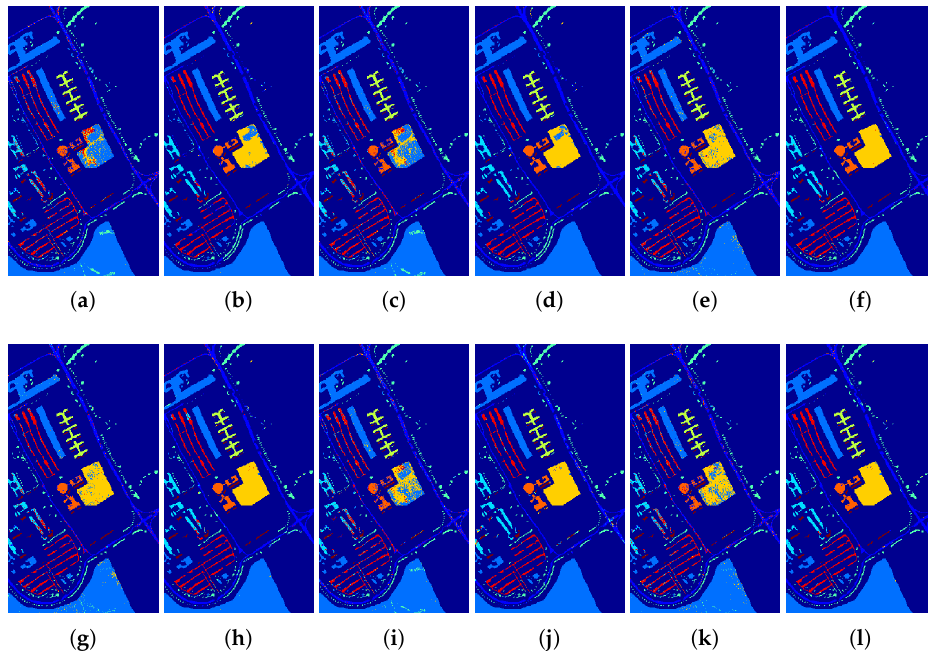
Figure 16. Classification maps of the ( a ) ELM, ( b ) ELM + GFFPC, ( c ) KELM, ( d ) KELM + GFFPC, ( e ) KSVM, ( f ) KSVM + GFFPC, ( g ) CNN, ( h ) CNN + GFFPC, (i) MELM, ( j ) MELM + GFFPC, and the proposed ( k ) DKELM, and ( l ) DKELM + GFFPC for the University of